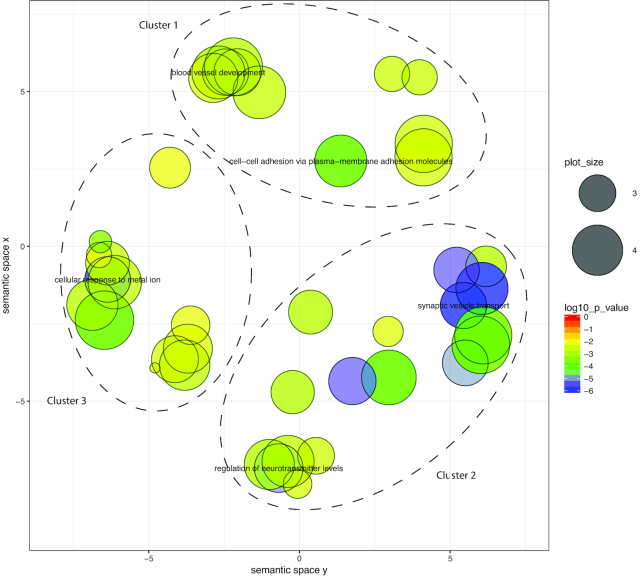
Gene ontology biological processes over-enriched within Medusozoa-specific orthogroups visualized using ReViGO. Over-representation analysis was performed with ClusterProfiler, with a P-adjusted cutoff of 0.01. Color indicates log10-transformed P-adjusted value. Terms are plotted within an x-y semantic space, in which similar terms are clustered within closer proximities. Color indicates P-value and circle size indicates frequency of GO term in the Cassiopea database.